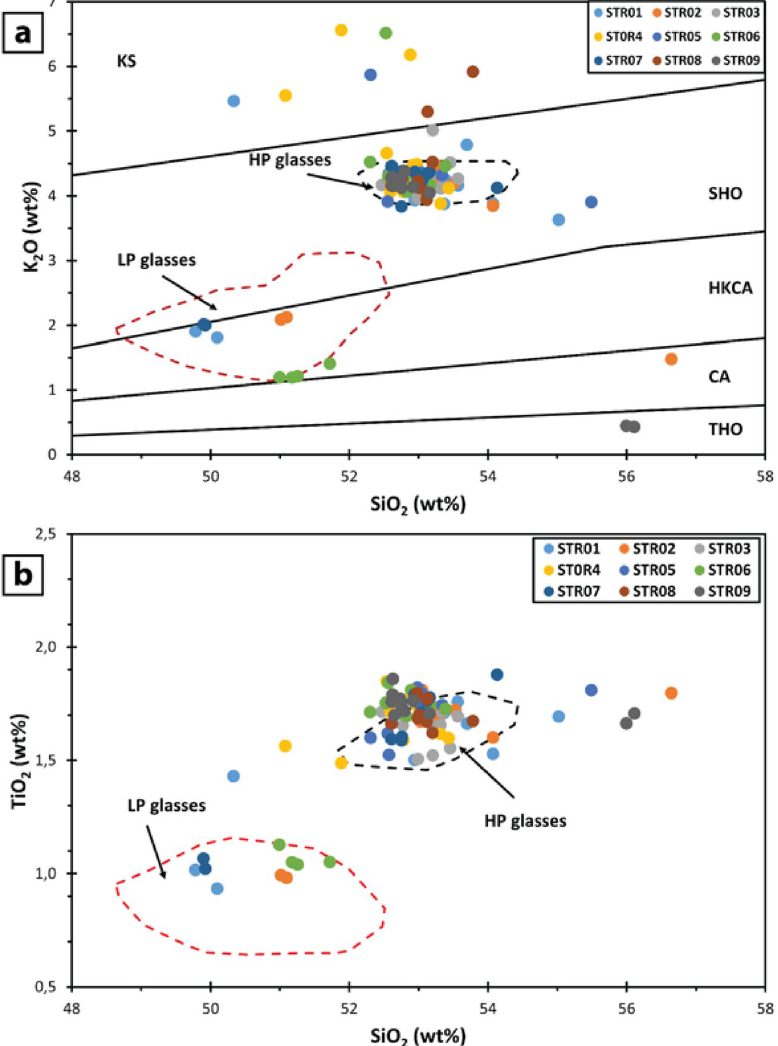
Figure 6. Plots of geochemical composition on groundmass glass. ( a ) is the SiO 2 vs K 2 O plot (modified after Peccerillo and Taylor 31 ). Compositional fields defined with the dashed lines are from Pichavant et al. 39 and represent the compositions of 2019 paroxysms and of typical products erupted at Stromboli during the ordinary (HP; High Porphyricity) and paroxysmal (LP; Low Porphyricity) activities. ( b ) represents the SiO 2 vs TiO 2 plot showing that silica-rich and low-alkali groundmass in ( a ) have the same TiO 2 composition of the HP